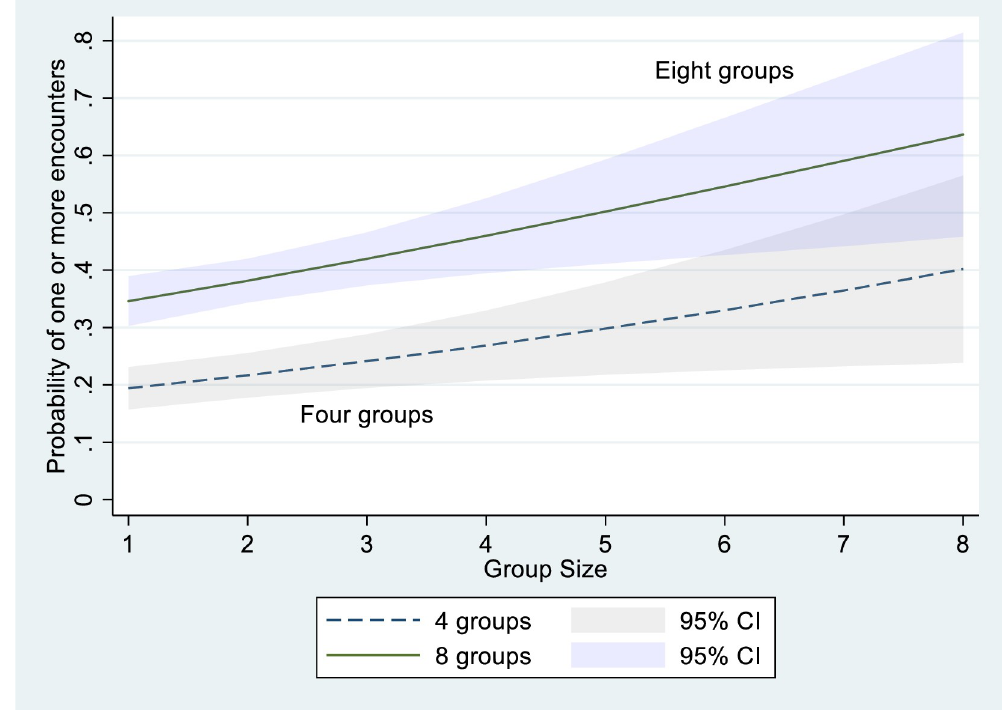
Fig 9. Probability of an encounter over group size and the number of groups